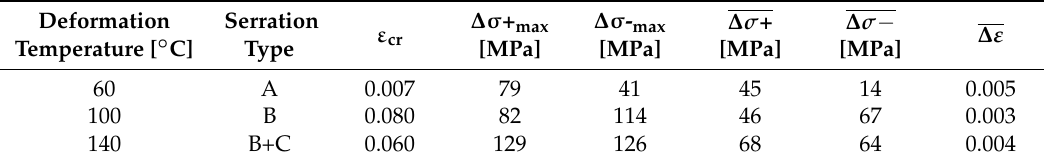
Table 3. Detailed characteristics of serration flow at various deformation